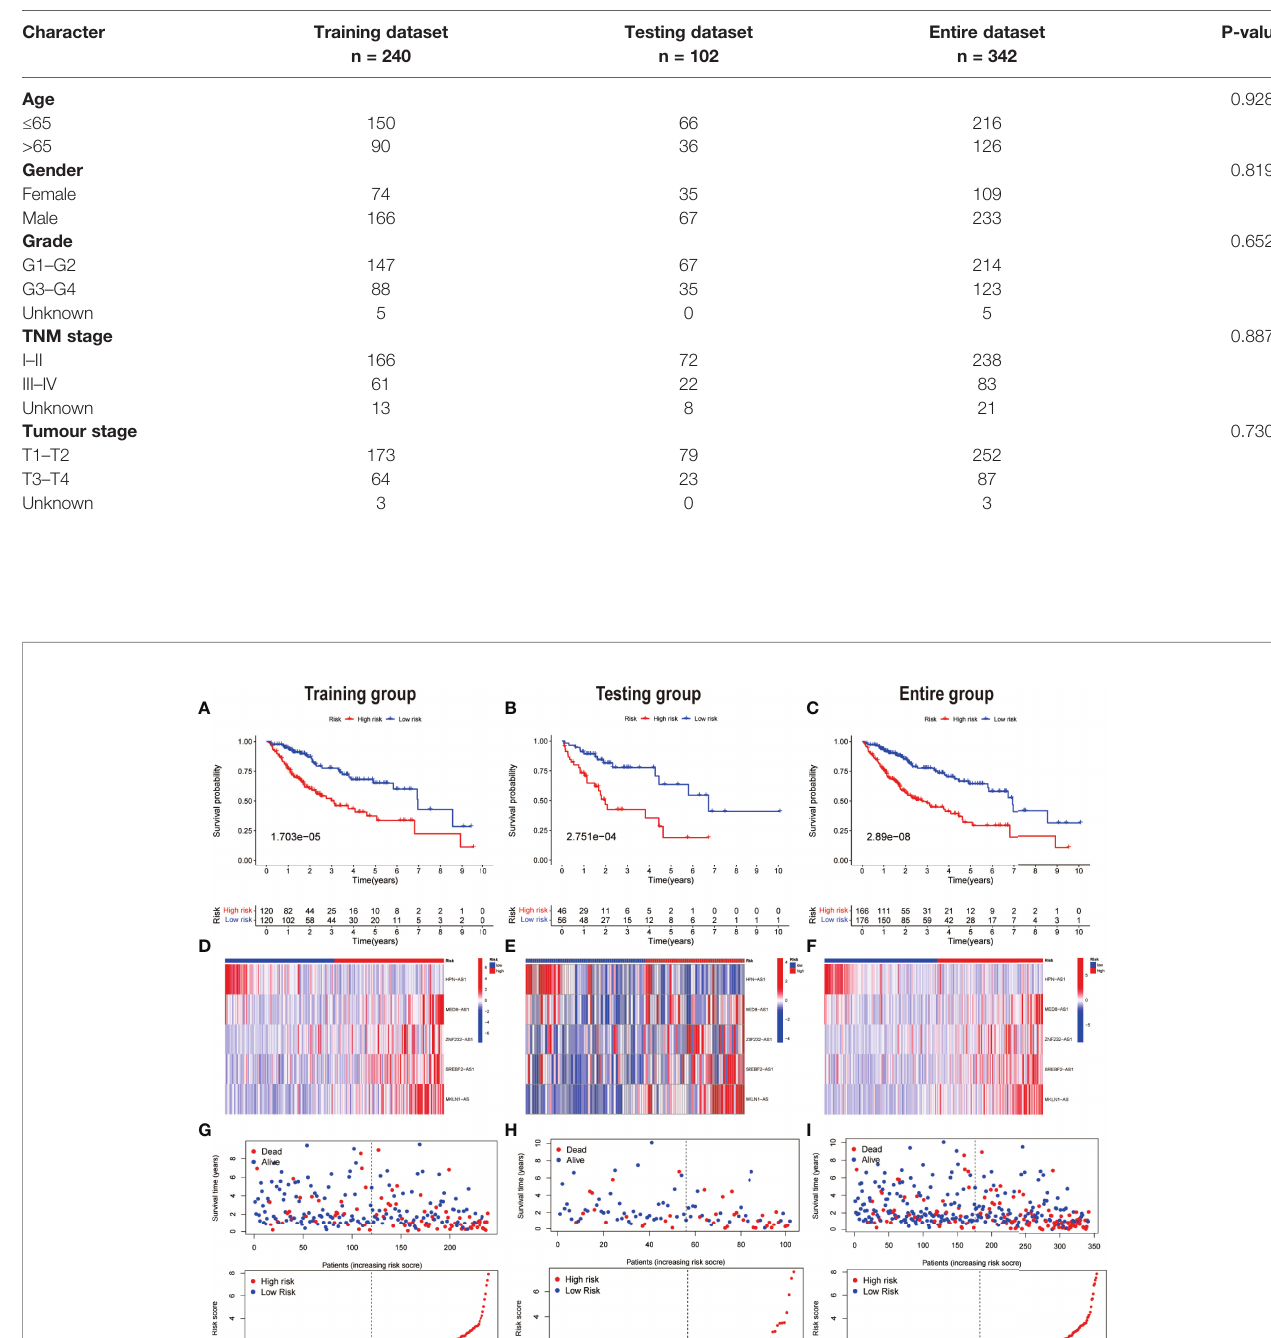
TABLE 1 | Clinical features of 342 patients with hepatocellular carcinoma.